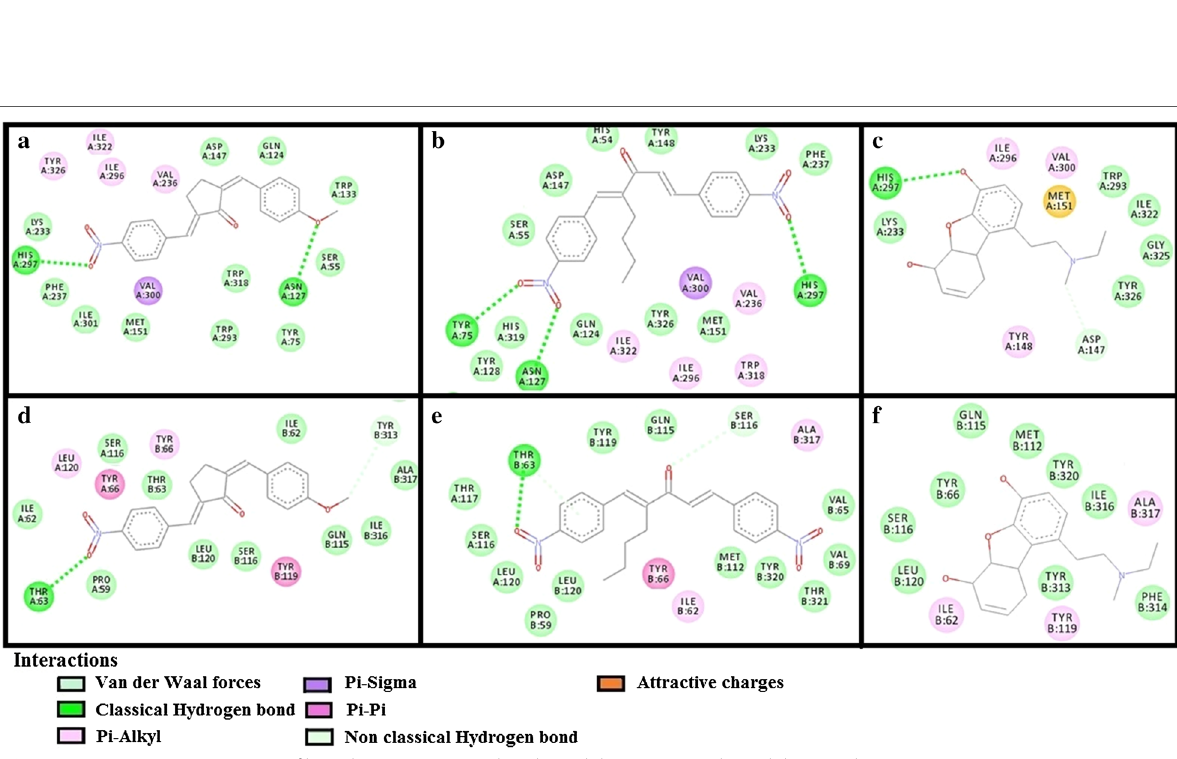
Fig. 5 a – c Represents interactions of ligands: (2 E ,5 E )‑2‑(4‑methoxybenzylidene)‑5‑(4‑nitrobenzylidene) cyclopentanone (AK‑1a), (1 E ,4 E )‑4‑(4‑nitro benzylidene)‑1‑(4‑nitrophenyl) oct‑1‑en‑3‑one (AK‑2a) and morphine with target: mu receptor respectively. d – f Represents interactions of AK‑1a, AK‑2a and morphine with target: kappa receptor respectively, drawn through Biovia Discovery Studio Visualizer client